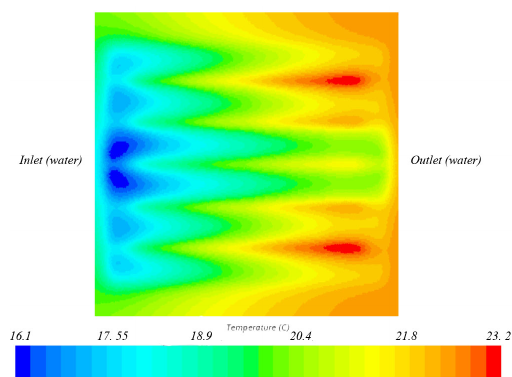
Fig. 7. Temperature on the contact surface: PV panel/FC-72 (‘hot’ minichannel).